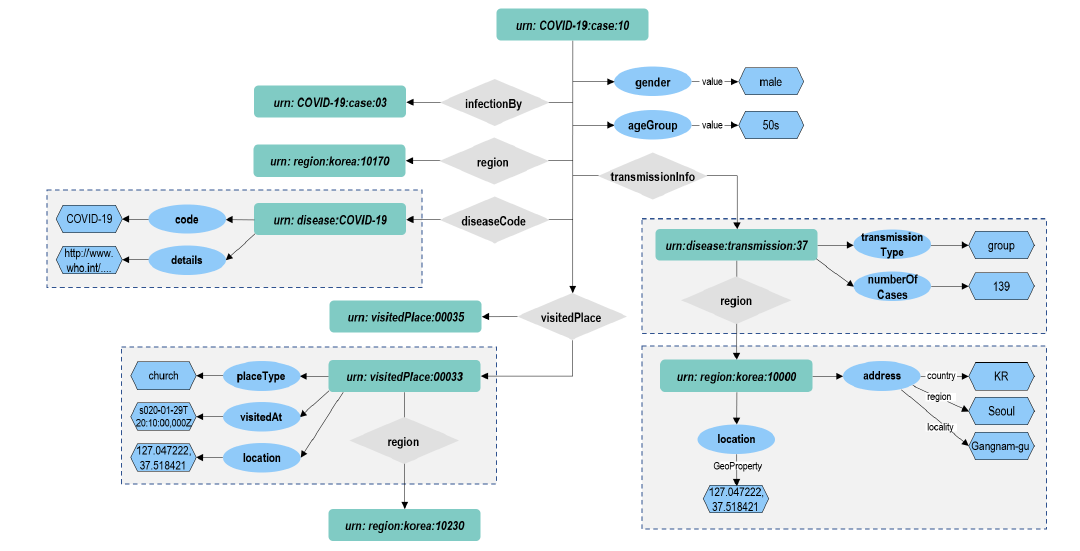
Figure 4. Infection NGSI-LD Entity Data